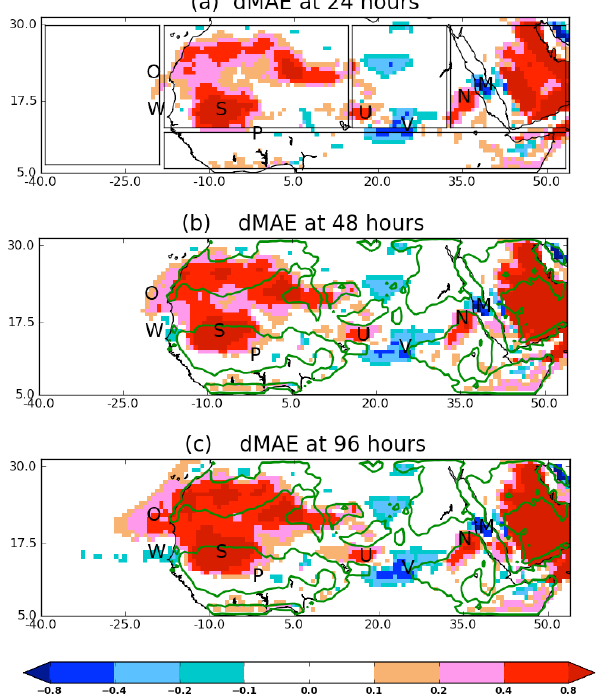
Fig. 12. Result of the verification experiment. The green contours enclose areas of strong friction velocity.